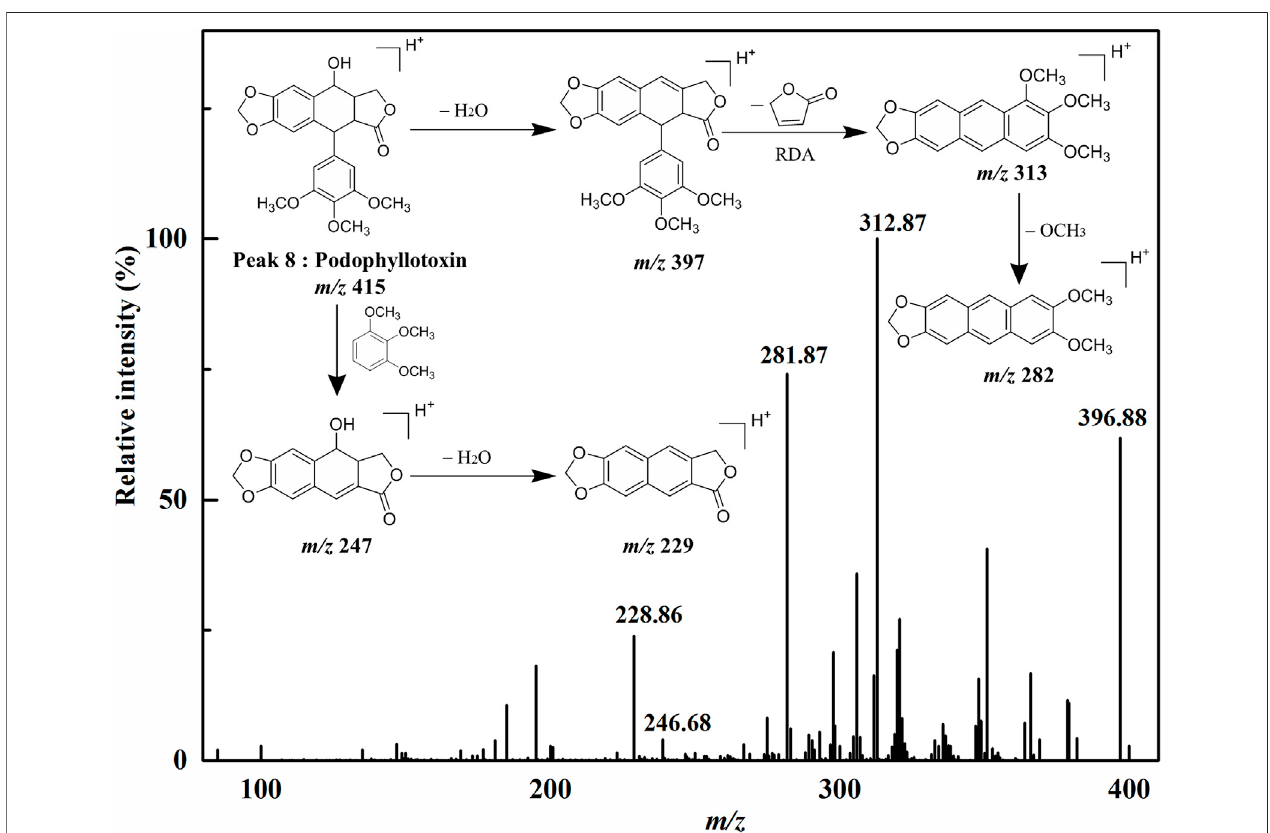
FIGURE 3 | ESI-MS/MS spectra and the proposed fragmentation pathways of Peak